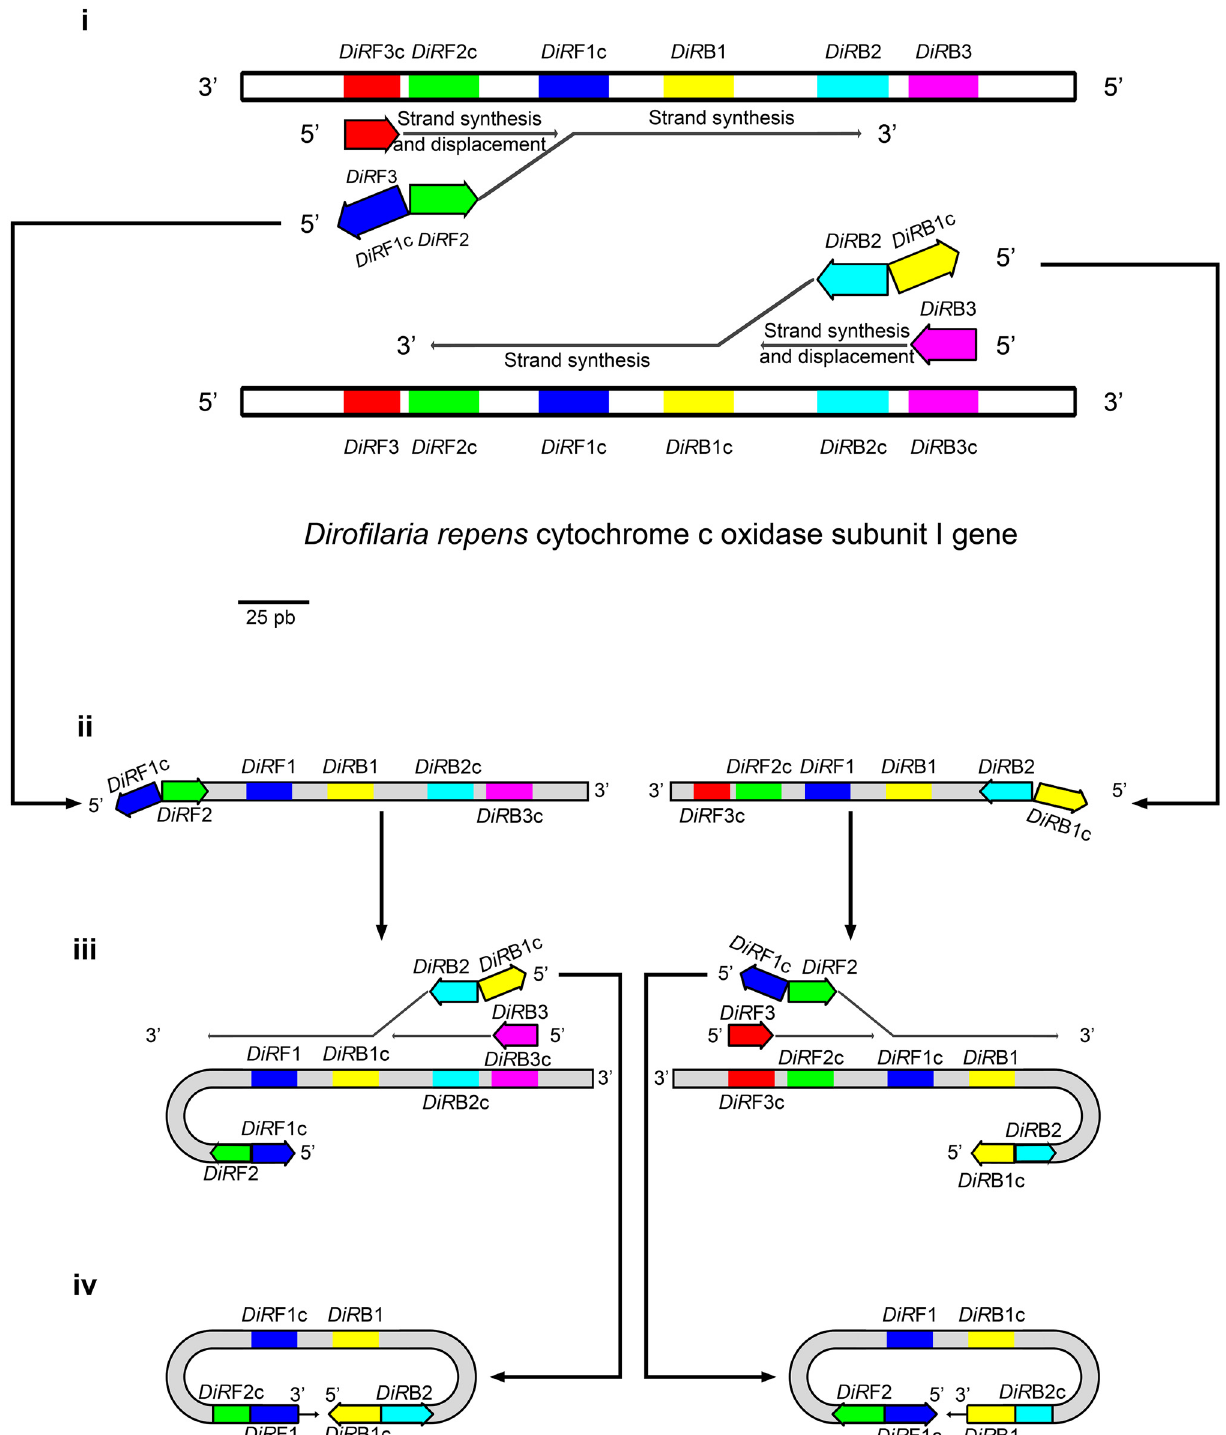
Fig 1. Relative positions of LAMP primers within the cytochrome c oxidase gene of D . repens . The first steps of the LAMP reaction are also depicted. i) Primers F3/B3, and DIR F2/ DIR B2 (parts of DIR FIP and DIR BIP, respectively), recognize and anneal to their respective complementary targets. The DNA synthesis starts and the strand displacement activity of the DNA polymerase let the strand synthesized from DIR F2 and DIR B2 to be detached from the template strand. ii) The displaced neo-synthesized strands bring, at their termini, DIR F1c and DIR B1c that iii) will self-anneal to the DIR F1 and DIR B1 loci, respectively, thus forming a secondary structure with a loop. DIR B3/ DIR F3